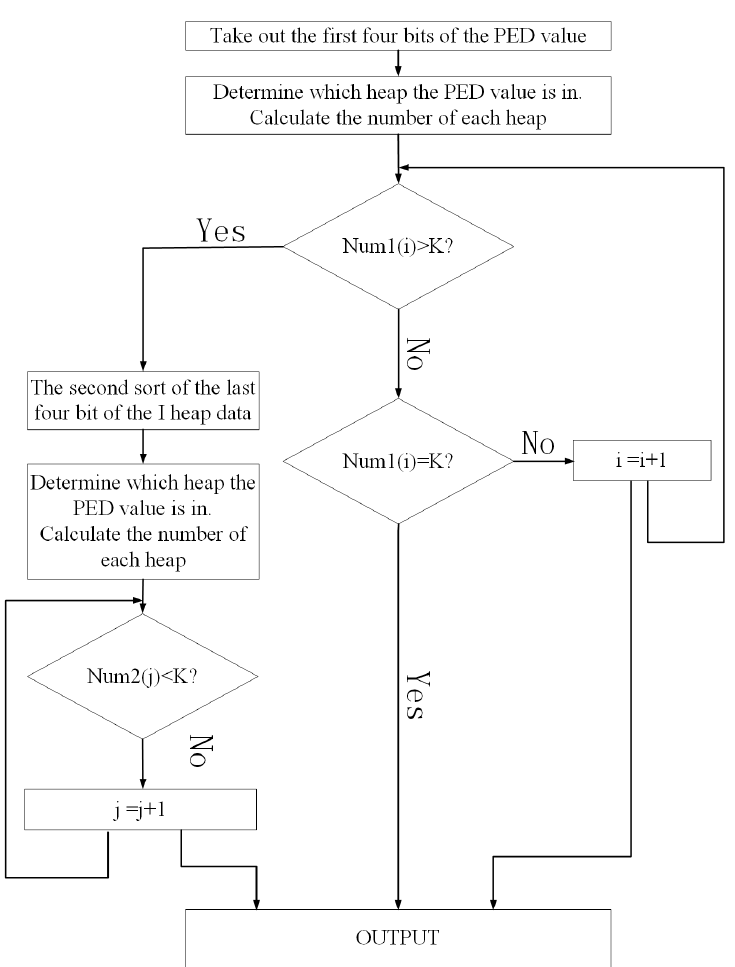
Figure 9. Flowchart of multiple 8-bit data